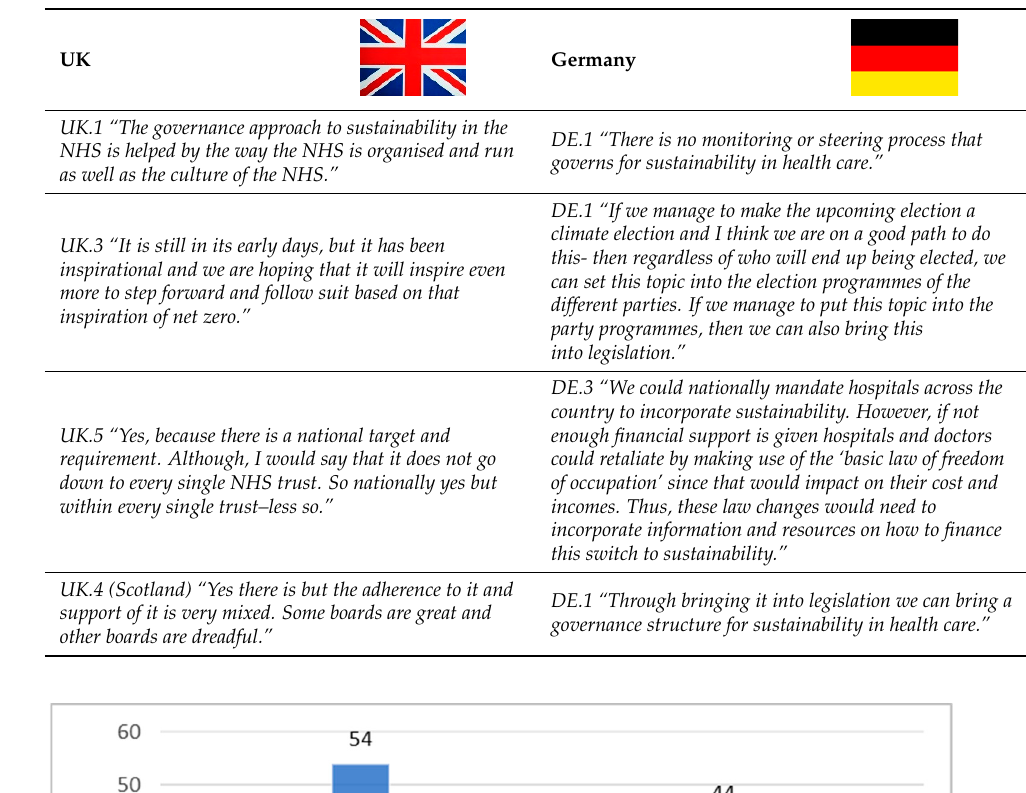
Table 3. Governance approach to sustainability UK vs. Germany.